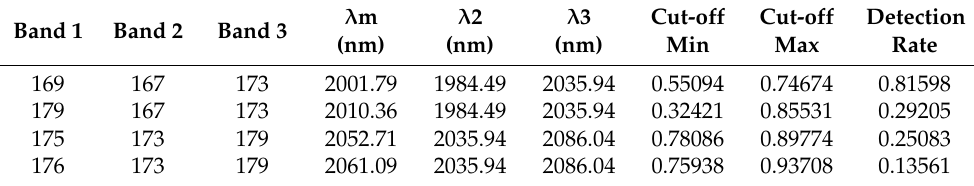
Table 3. CO 2 -CIBR detection rate.